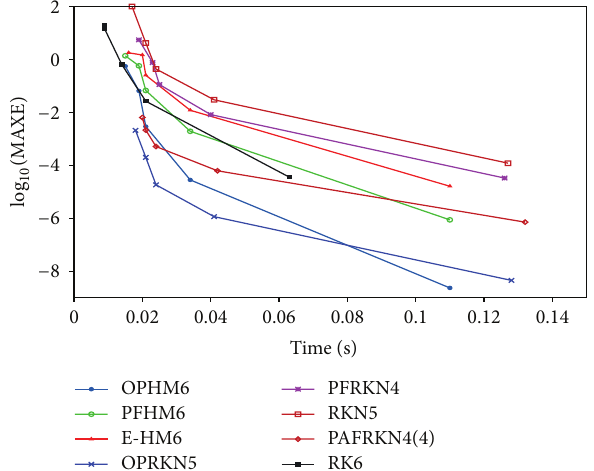
= 10 4 and ℎ = 0.125/ end